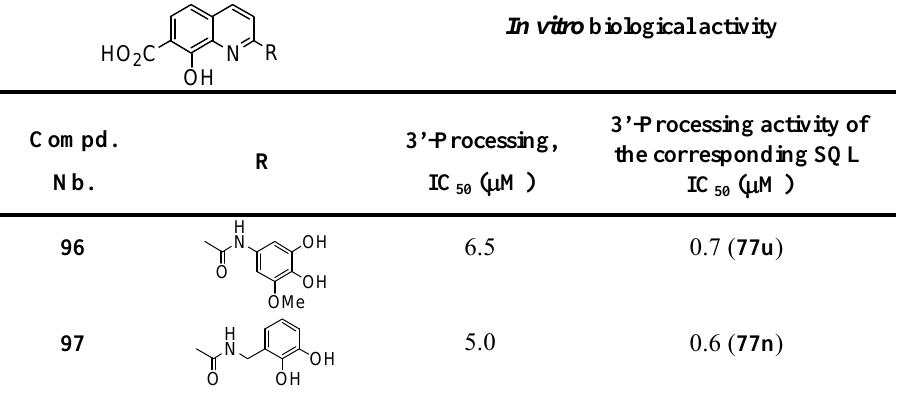
Table 9. HIV-1 IN inhibitory potency of spacer modified